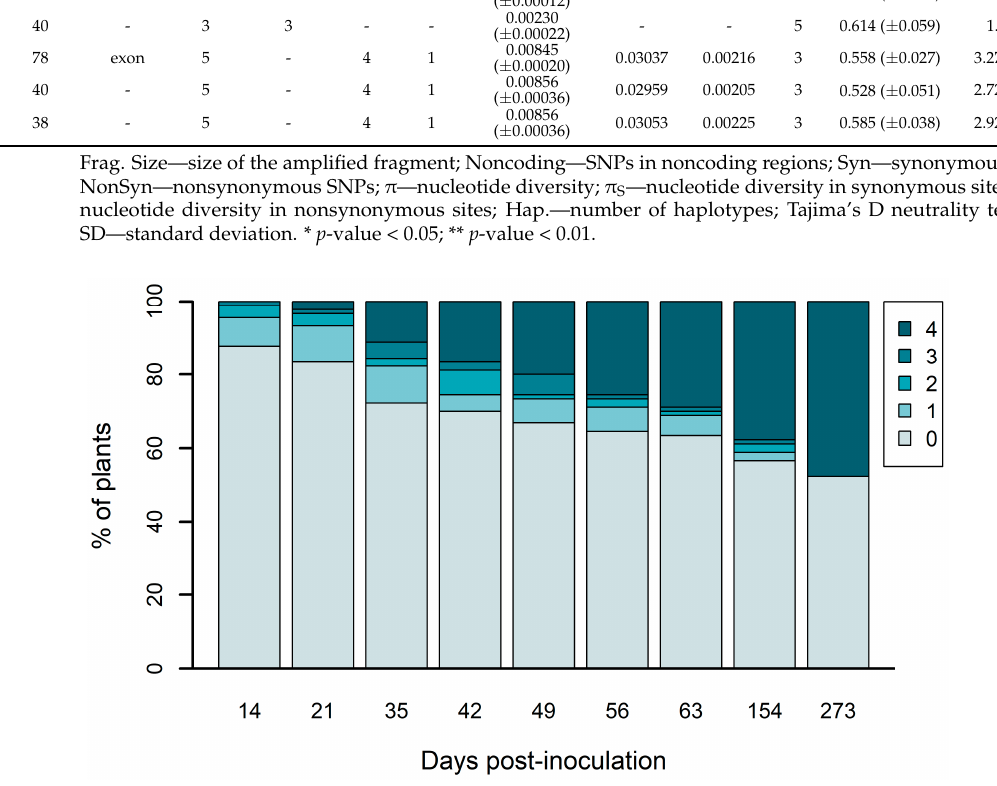
Figure 3. Pine wilt disease symptoms progression in Pinus pinaster plants according to a symp- toms scale of 0 to 4. This scale is based on the percentage of wilting or brown needles in each observed plant: 0—0% of the needles presented symptoms; 1—1 to 25%; 2—26 to 50%; 3—51 to 75%; 4—76 to 100%. Dpi—days post-inoculation. Table 3. Summary of genetic diversity estimates for the six sequenced gene fragments.